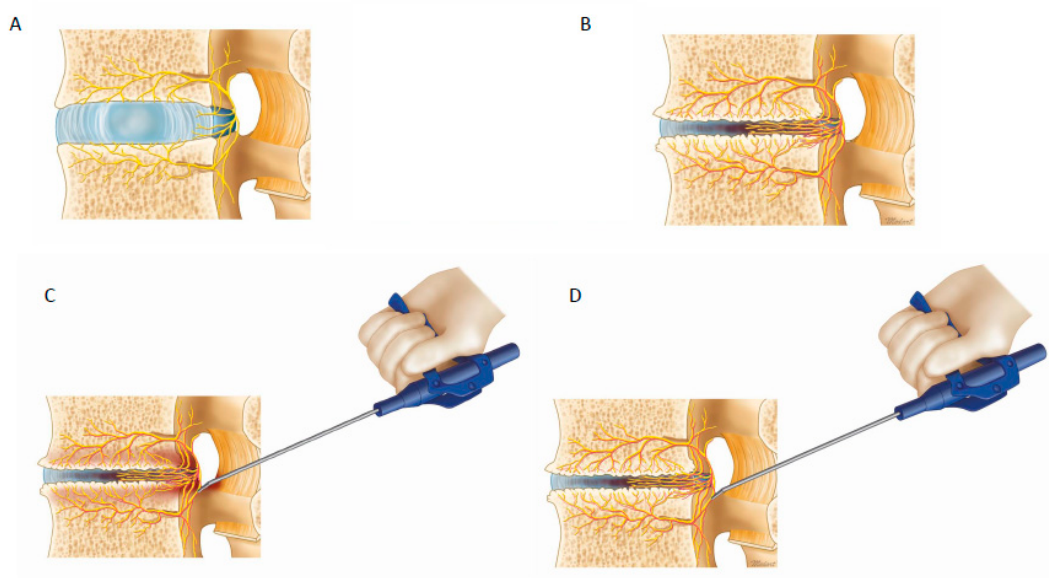
Figure 3. Radiofrequency ablation of the sinuvertebral nerve and basivertebral nerve. In ( A ), normal disc, there is a presence of sinuvertebral nerve branches but no pathological neurotization and no neovascularization. ( B ) Pathological neovascularization and neurotization around the disc with hyperalgesia from signals transmitted by the sinuvertebral nerves and basivertebral nerves. ( C ) When radiofrequency is applied to the pathological hyperalgesic nerve fibers, there is twitching of the patient’s buttock muscles. ( D ) As radiofrequency ablation continues, the pathological neurotized nerve fibers are coagulated and twitching of the buttock muscles stopped in our case series. The patients performed better in clinical outcomes if they had initial buttock twitching and subsequent stoppage of twitching after radiofrequency